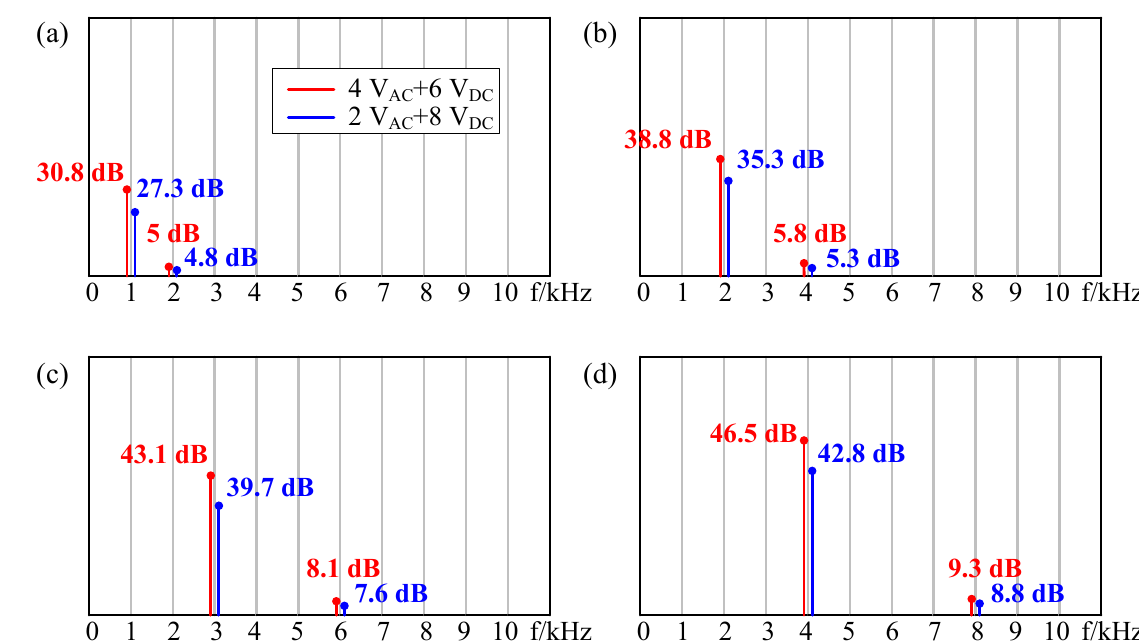
Figure 12. The results with DC excitation were larger than those AC excitation at frequencies of ( a ) 1 kHz, ( b ) 2 kHz, ( c ) 3 kHz, and ( d ) 4 kHz.